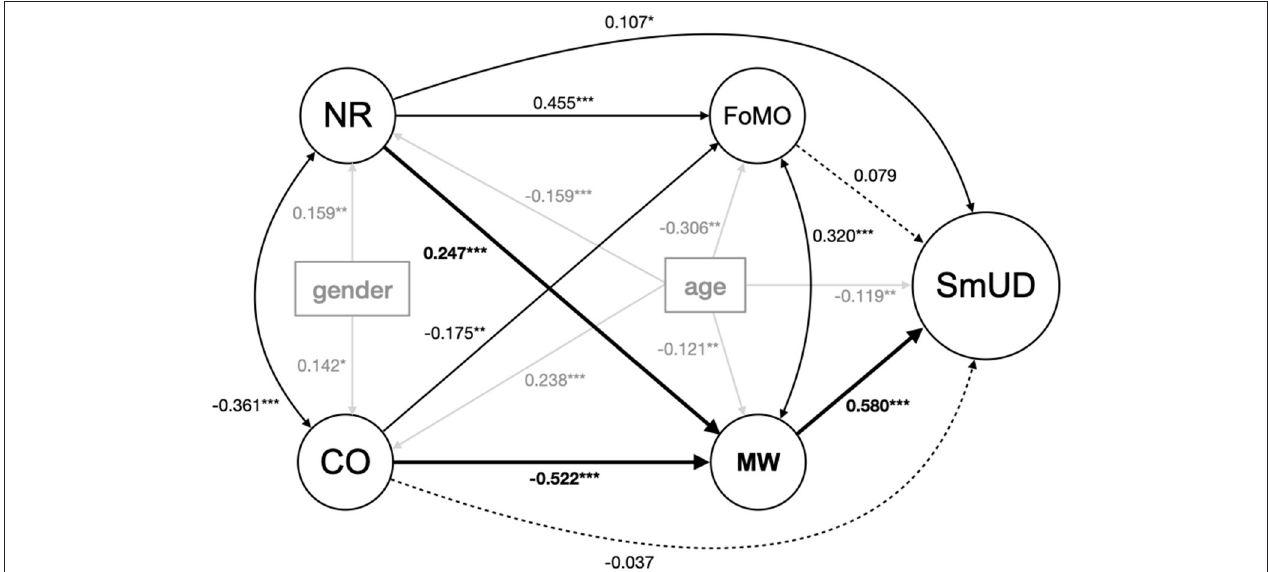
FIGURE 2 | Results of the structural regression model displaying the standardized path coefficients. The graphical representation of the model displays latent constructs as circles (NR, CO, FoMO, MW, SmUD) and measured covariates (age, gender) as rectangles (manifest variables). Paths illustrated with one arrow tip signify a regression on the construct they point at, and two arrow tips indicate a covariance between two constructs. For reasons of clarity, items of the latent variables are not presented here, but were used to calculate the model. CO, Conscientiousness; NR, Neuroticism; MW, Mind-Wandering; FoMO, Fear of Missing Out; SmUD,